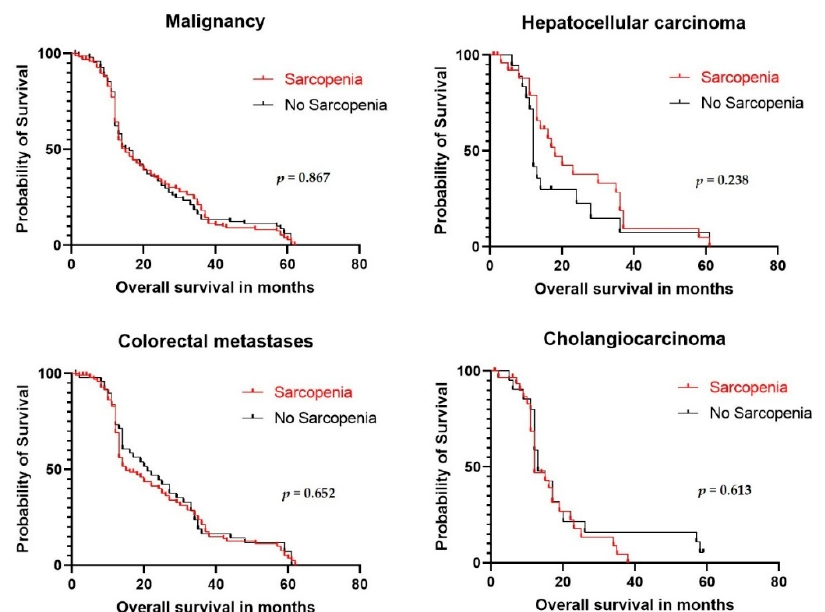
Figure 3. Overall survival for malignancies after hepatectomy. Results are stratified by the presence of sarcopenia, assessed with the skeletal muscle index (SMI).